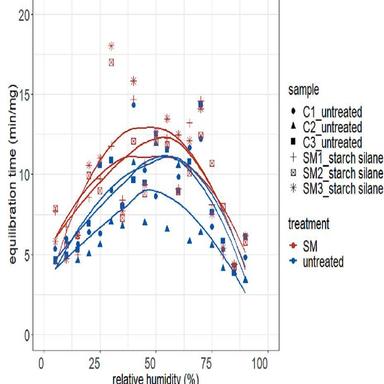
The dynamic absorption of moisture from moist air to establish an equilibrium moisture content of samples.